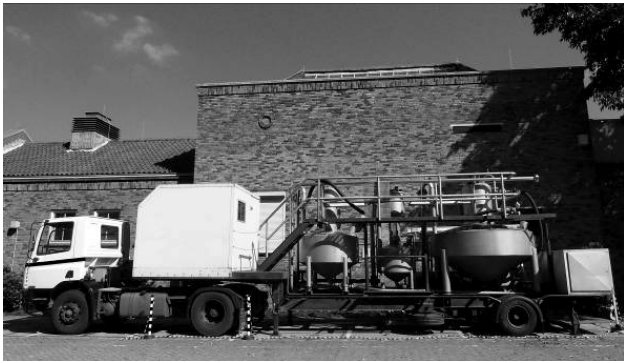
Fig. 1. Proving tanks 500, 1500 and 4000 L on trailer.